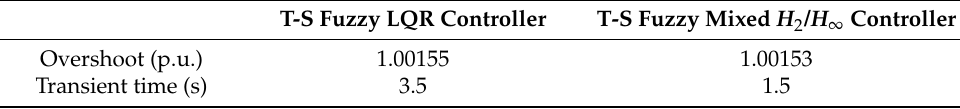
Table 4. Comparison of performance indicators of different controllers in Case